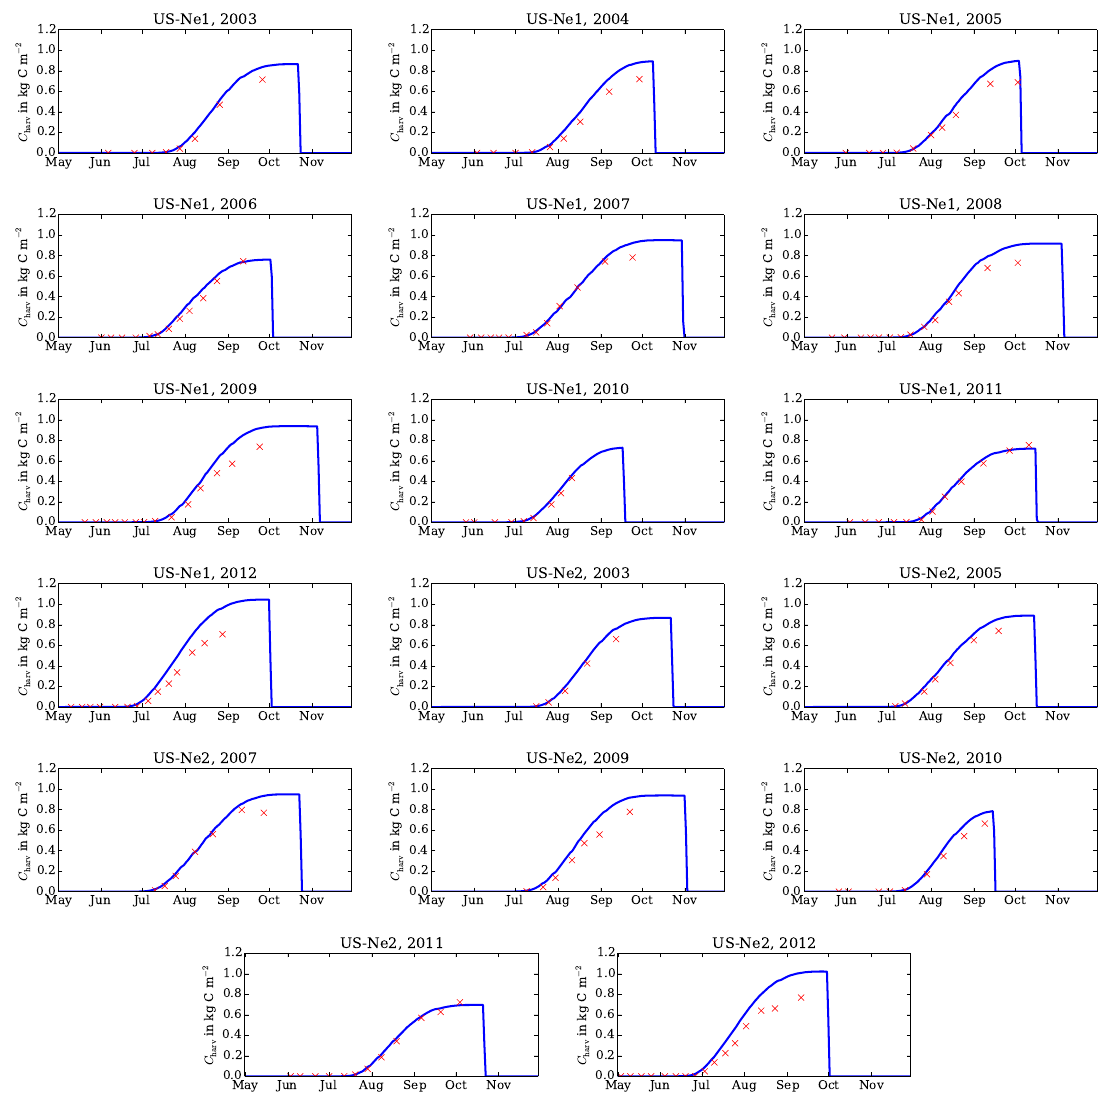
Figure 27. Time series of the carbon in the harvest pool (reproductive parts of the crop and yellow leaves). Irrigated maize at the Mead FLUXNET sites US-Ne1 and US-Ne2; blue: model; red: observations. JULES runs have the crop model switched on and the input parameters in Tables 1, 2, 3, and